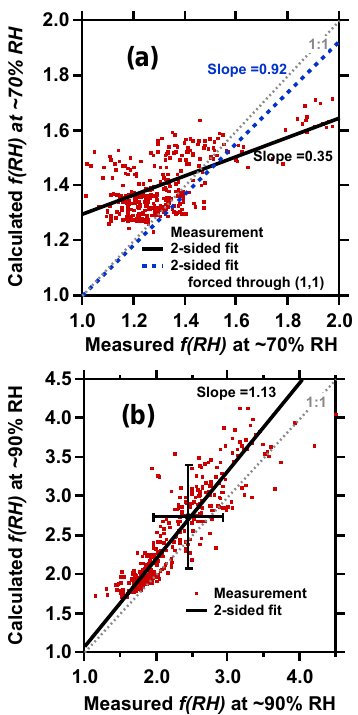
Figure 5. (a) Calculated f (RH) compared with observed f (RH) at ∼ 70% RH using the methodology in Fig. 1a for all analyzed data. Lines are two-sided least-squares (orthogonal distance regres- sion) fits to the data. The dashed line is calculated assuming the line passes through (1, 1). (b) As in (a) , but for ∼ 90% RH. Organic hygroscopicity ( κ chem,OA ) is assumed to be